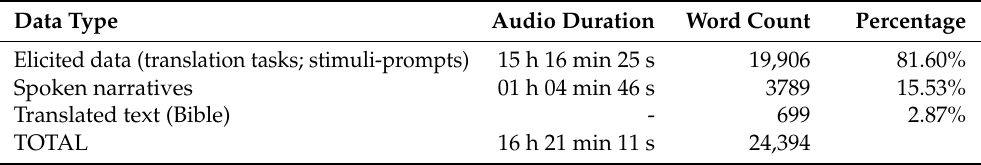
Table 3. Break-down of our corpus according to data type (genre). Data